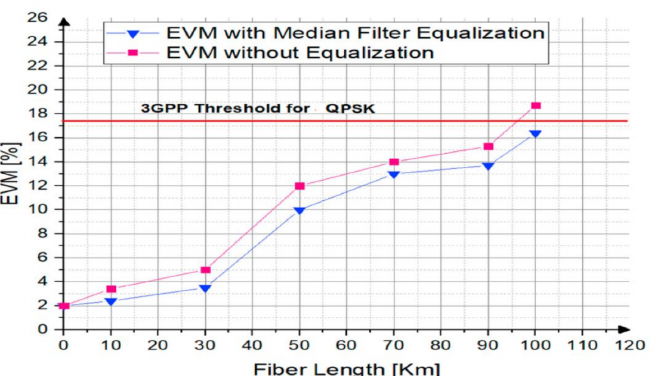
Figure 17. EVM results obtained before and after median filter equalization vs. the fiber lengths for the QPSK constellation.